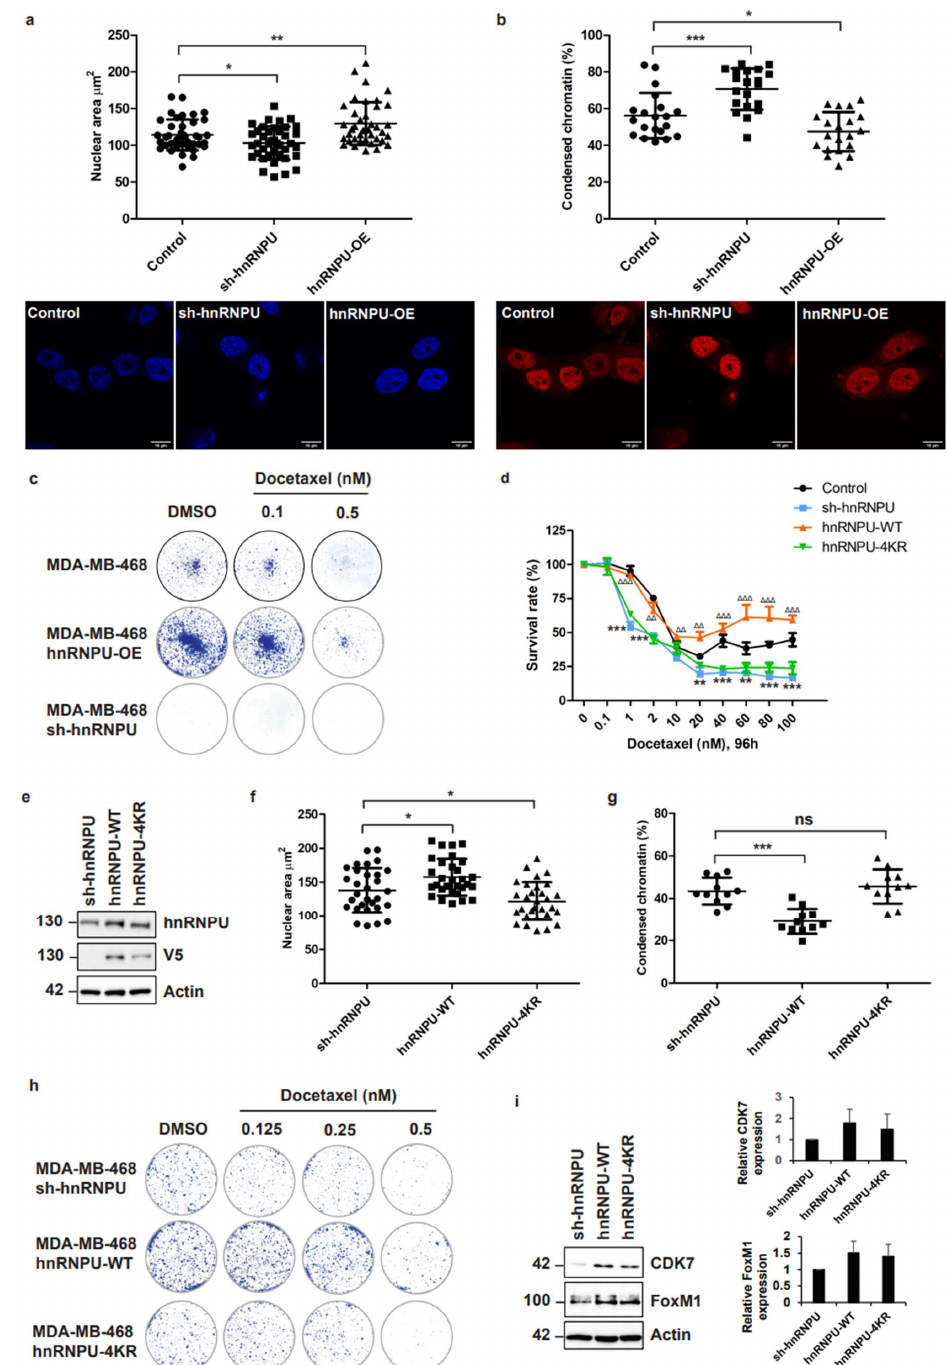
(Figure 6i). Thus, the modulation of the CDC20–hnRNPU axis could improve the chromatin Cancers 2022 , 14 , x condensation in TNBC, which in turn resensitizes cellular drug response.